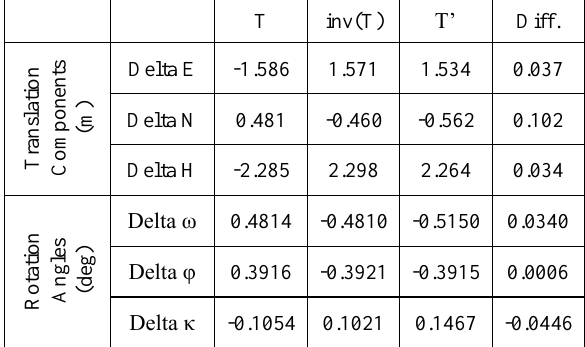
Table 2. Reliability of the ICP estimated transformation: T is the transformation that moves Block 3 towards Block 4;